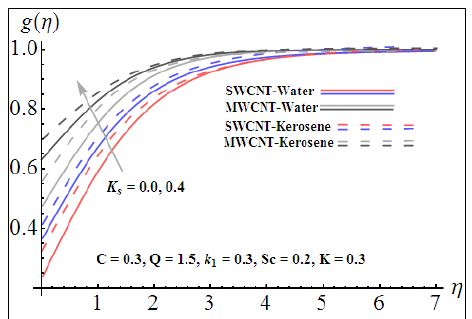
Figure 10. Behavior of g ( η ) for increased values of K .